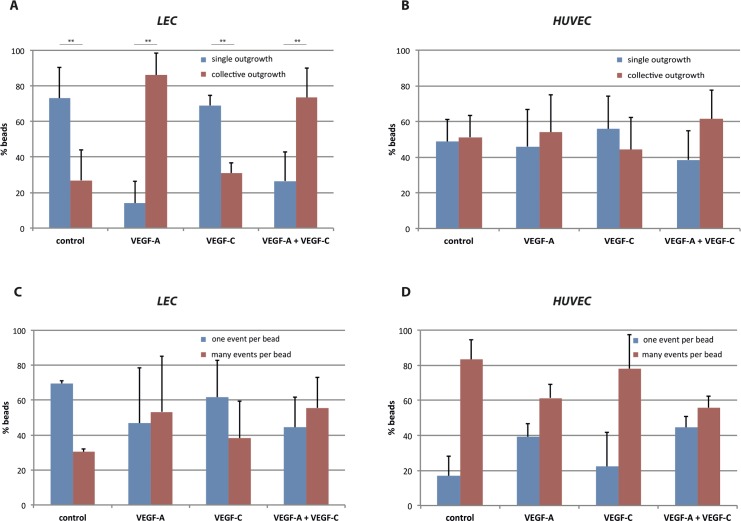
The presence of VEGF-A favors collective LEC outgrowth but has no effect on the mode of HUVEC outgrowth.(A,B) Bar graphs quantifying for LEC (A) and HUVEC (B) the % number of beads with single cell outgrowth (blue) and collective cell outgrowth events (red), counted in the absence or presence of 50 ng/ml VEGF-A, 200 ng/ml VEGF-C, or 50 ng/ml VEGF-A plus 200 ng/ml VEGF-C in the medium. (C,D) Bar graphs quantifying for LEC (C) and HUVEC (D) the % number of beads that gave rise to only one outgrowth event (blue) or multiple events (red) during the experiment, counted in the absence or presence of 50 ng/ml VEGF-A, 200 ng/ml VEGF-C, or 50 ng/ml VEGF-A plus 200 ng/ml VEGF-C in the medium. Statistical significance was tested with the chi-square test (S1 Table). p-values: LEC single vs. collective <0.0001, LEC one vs. multiple events per bead = 0.0454, HUVEC single vs. collective = 0.502, HUVEC one vs. multiple events per bead = 0.0356. ** p-value < 0.0001.